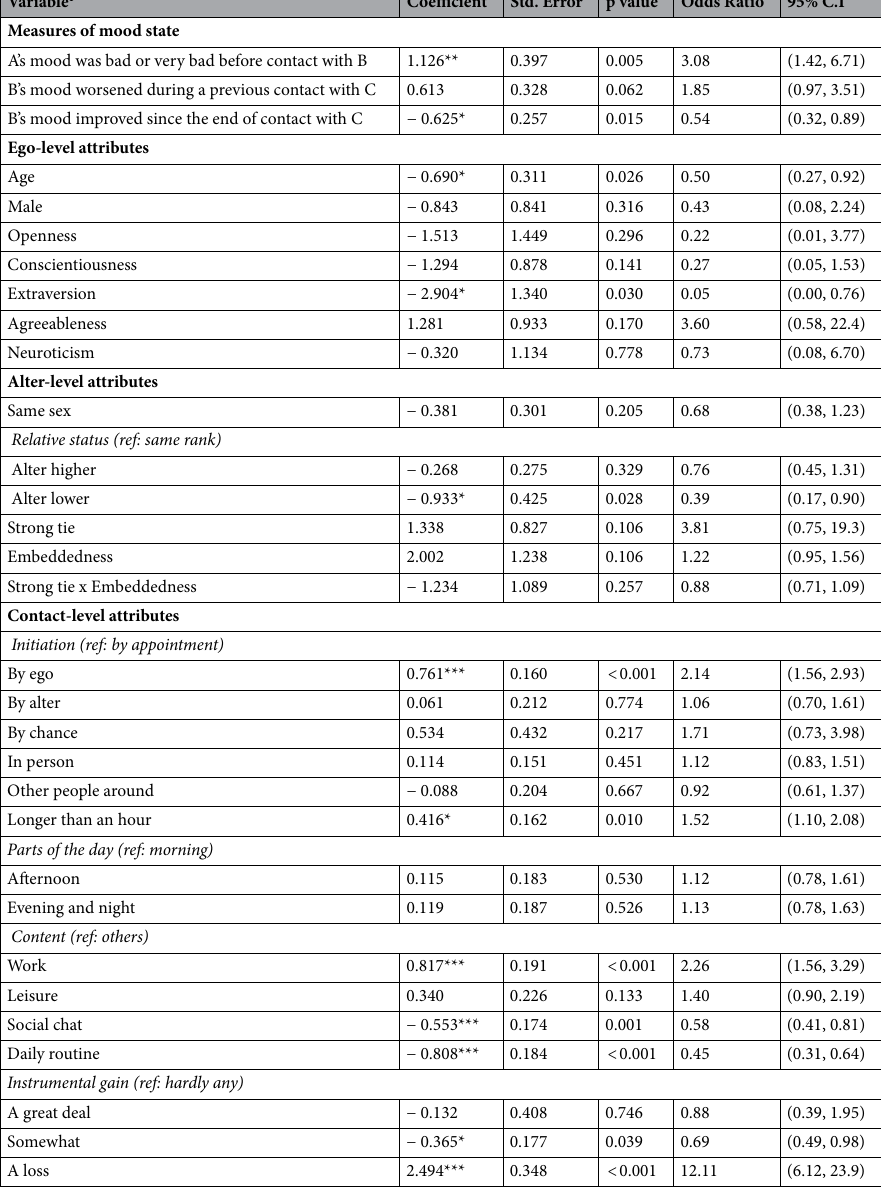
datasets. 1 All variables are binary except age, for which the odds ratio is calculated based on the increase